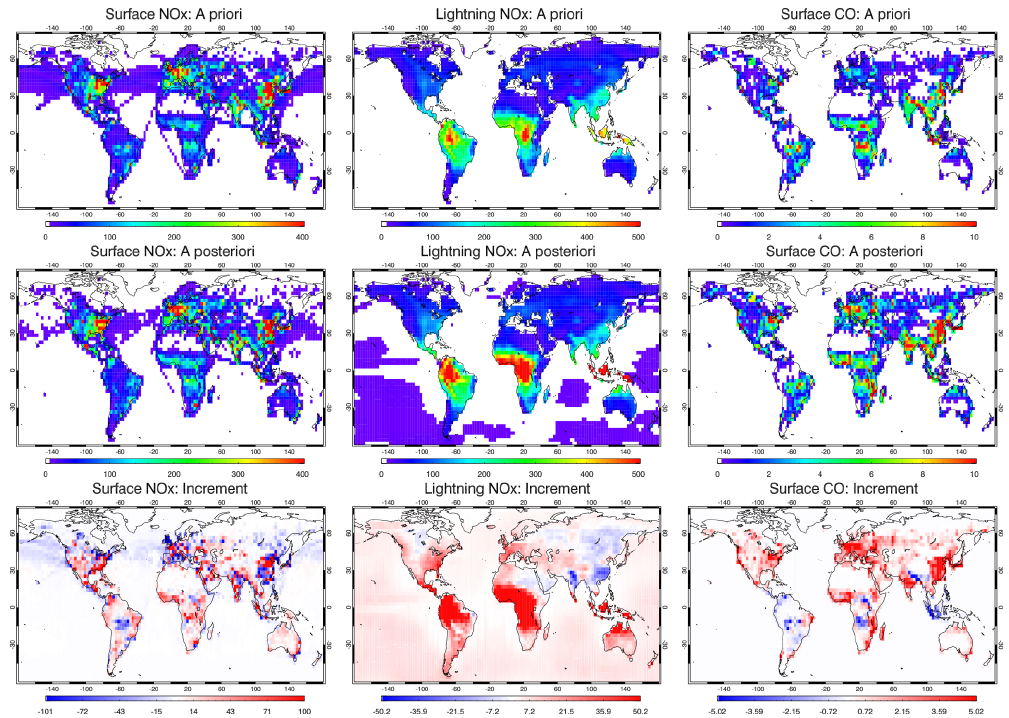
Figure 16. Global distributions of surface NO x emissions (in 10 − 13 kgm − 2 s − 1 ) (left column), LNO x sources (in 10 − 14 kgm − 2 s − 1 ) (centre column), and surface CO emissions (in 10 − 10 kgm − 2 s − 1 ) (right column) averaged over 2005–2012. The a priori emissions (upper row), a posteriori emissions (middle row), and analysis increment (lower row), i.e. the difference between the a posteriori and the a priori emissions, are shown for each